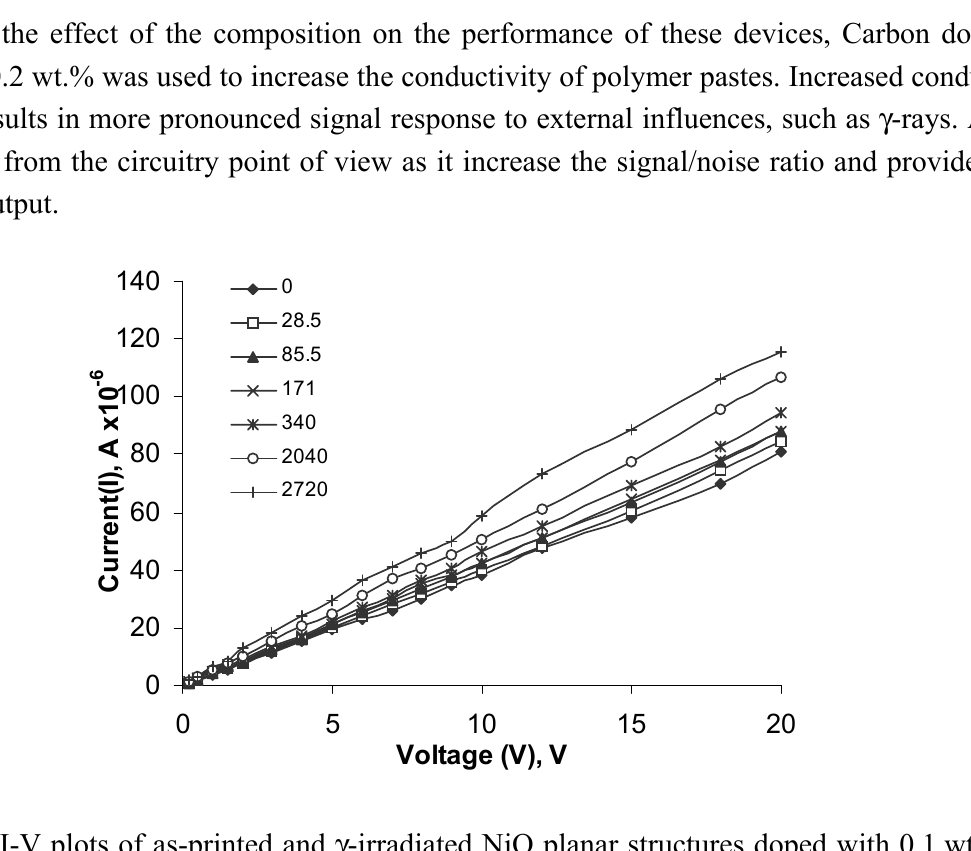
Figure 7. Plot of normalized current (I-I 3 V for NiO interdigitated planar structures.